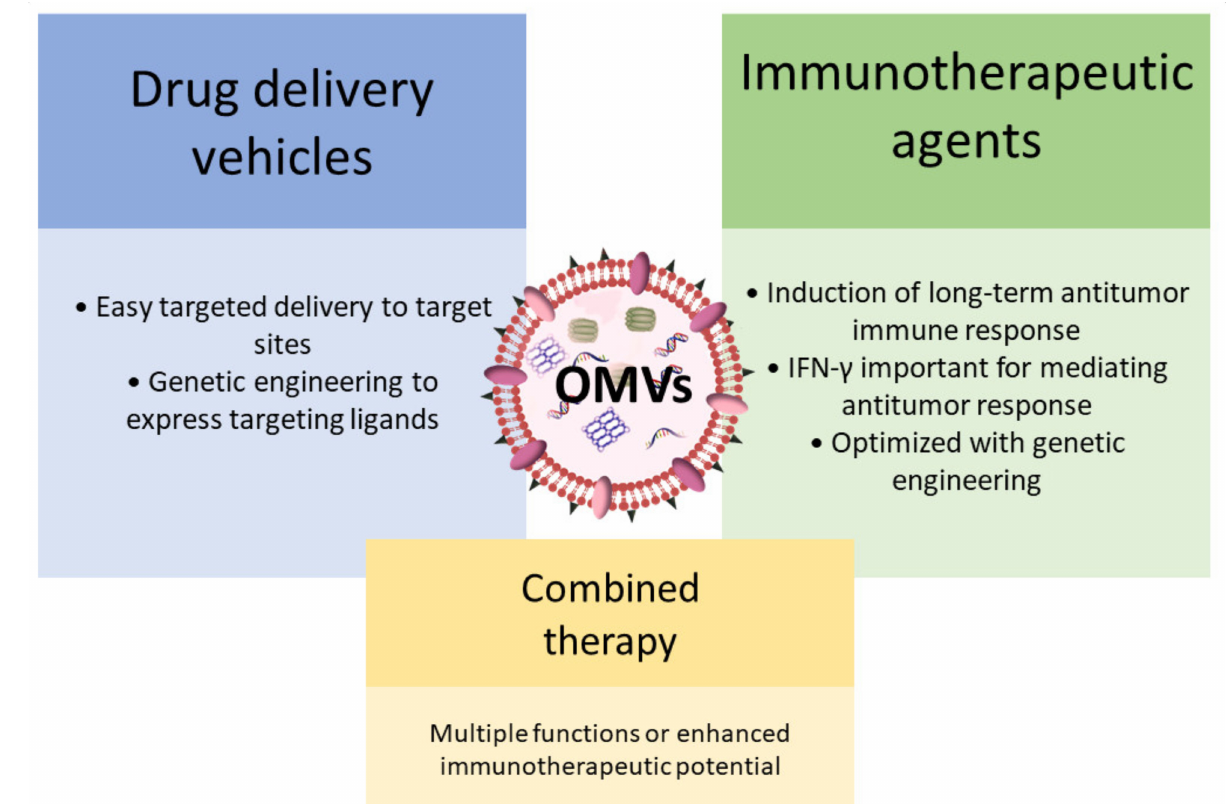
Figure 2. The use of OMVs in cancer